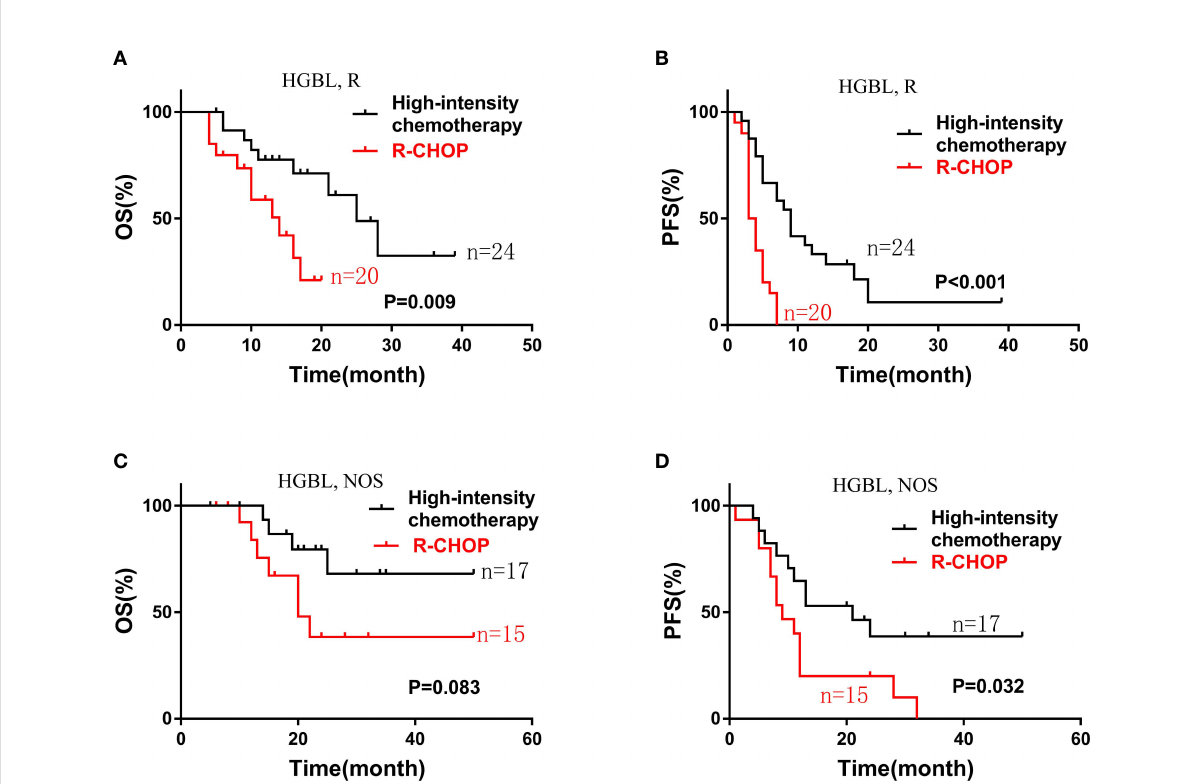
FIGURE 3 Kaplan-Meier curves of OS (A) and PFS (B) according to different induction chemotherapy regimen: high-intensity chemotherapy regimens (n=24) vs. R-CHOP (n=20) in patients with HGBLR. The OS (C) and PFS (D) curves of patients with HGBL, NOS strati fi ed by different induction chemotherapy regimen: high-intensity chemotherapy regimens (n=17) vs. R-CHOP